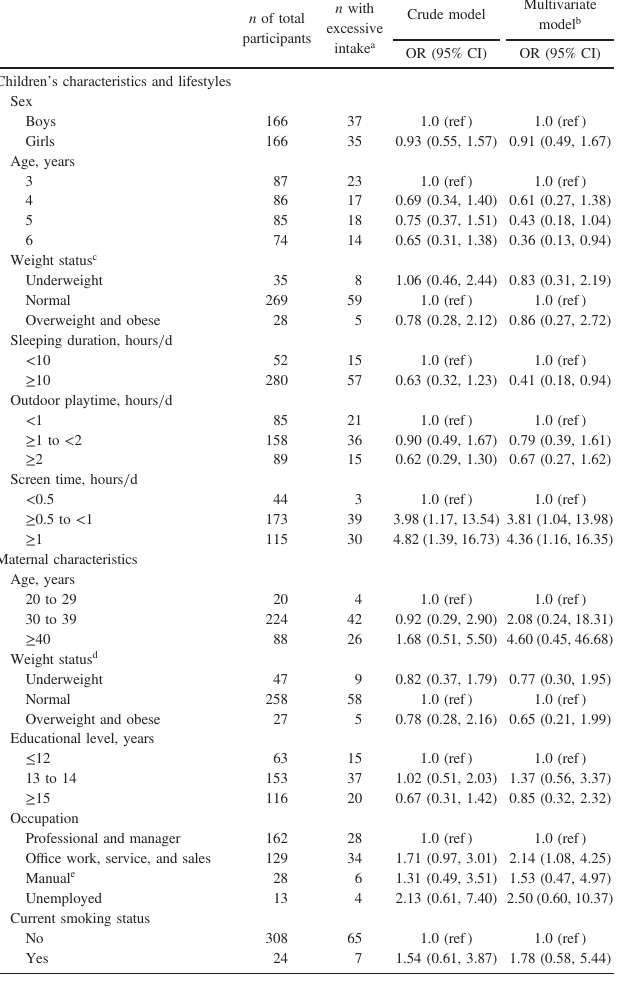
Table 4. Associations between selected characteristics and lifestyles and excessive free sugar intake in Japanese children aged 3 – 6 years ( n =